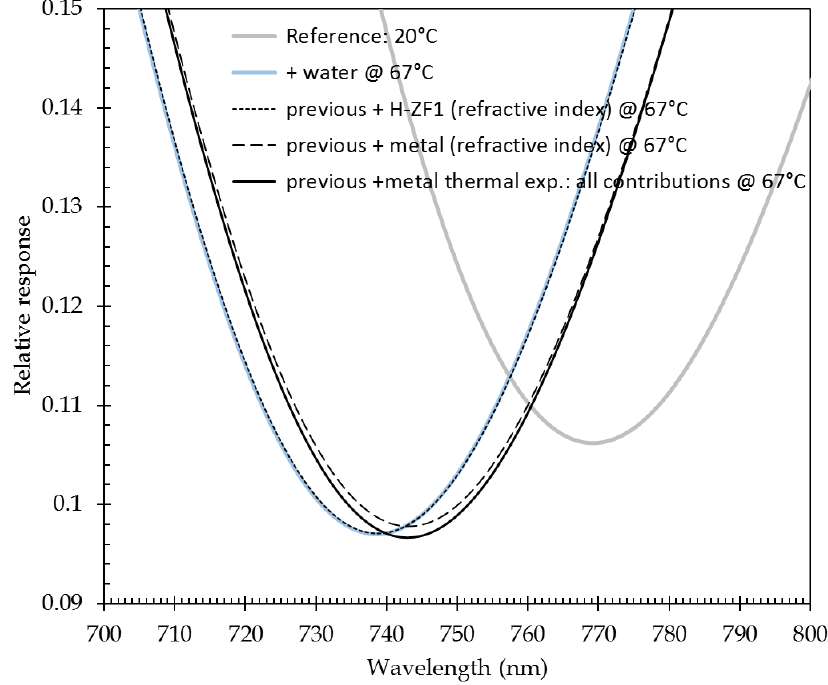
Figure 11. Effect of temperature-dependent parameters on the SPR response curve (here, for a 318-mA injection current, i.e., a 47 °C temperature rise versus ambient). Compared to Figure 10, a zoom on the minimum of the response curve has been made.